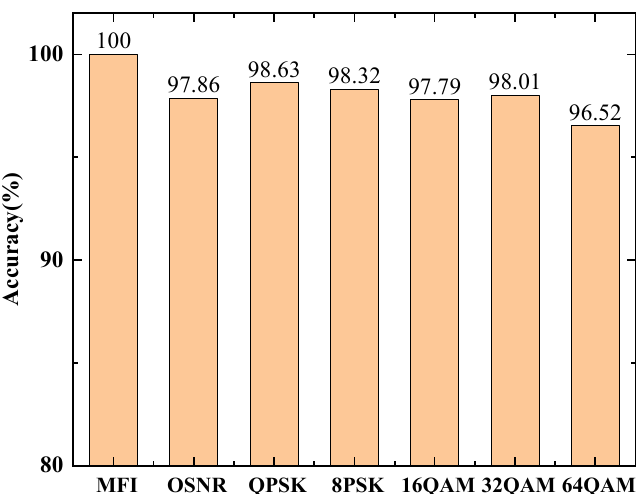
Figure 12. Accuracies for MFF-Net trained on data from three different transmission distances (80 km, 160 km, and 240 km).